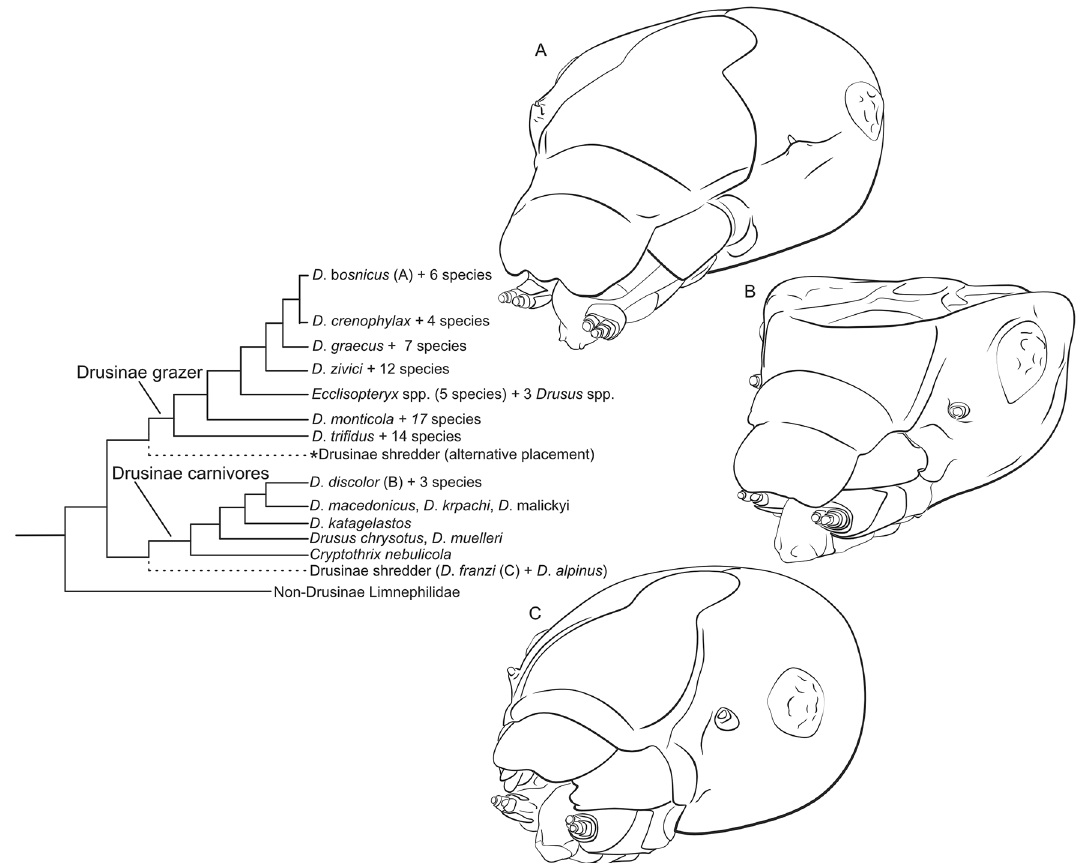
Figure 1. Relationships of Drusinae evolutionary lineages based on published phylogenies 13,14 . Drusinae scraping grazers and Drusinae filtering carnivores are monophyla; placement of Drusinae shredders is equivocal as sister of either Drusinae grazers or Drusinae carnivores. Gross head capsule morphology of Drusinae grazers ( A , Drusus bosnicus ) and Drusinae shredders ( C , D . franzi ) is quite similar, and differs distinctly from that of Drusinae carnivores ( B , D . discolor ). Figures not to scale; del. Vitecek. This figure was built using the Affinity Suite, version 1.10.4 (Serif Europe Ltd., https:// affin ity. serif.